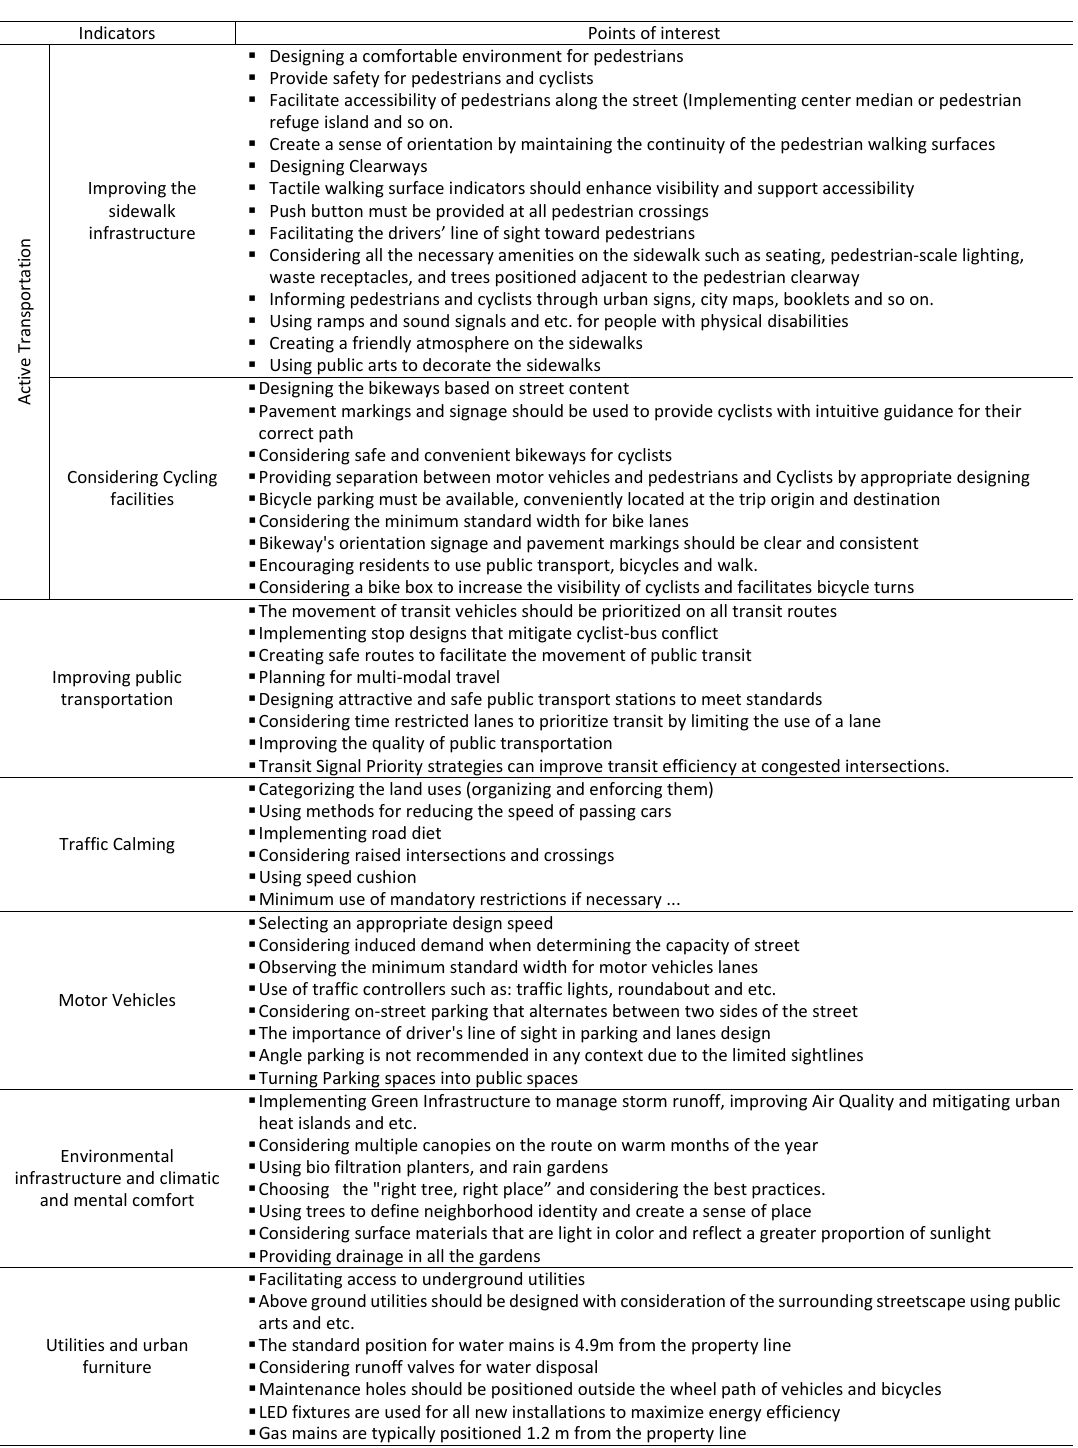
Table 1. Indicators of Complete Streets Table 1 : Indicators of Complete